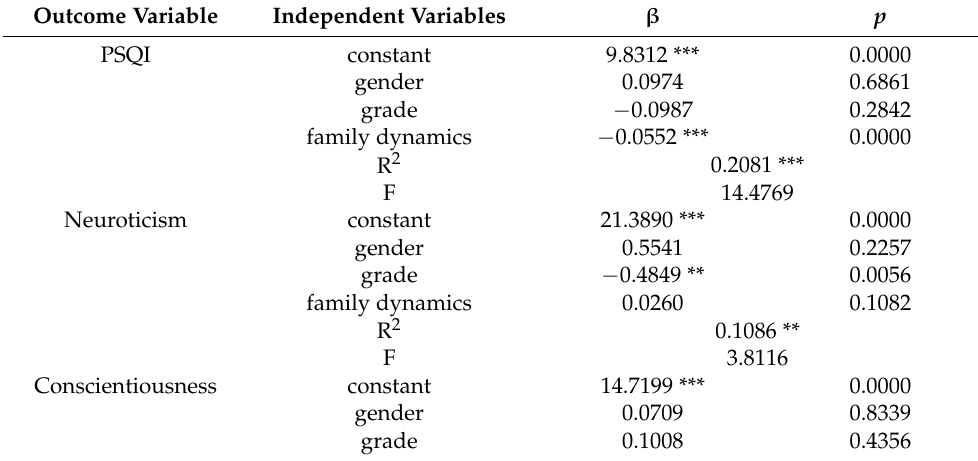
Table 3. Mediation